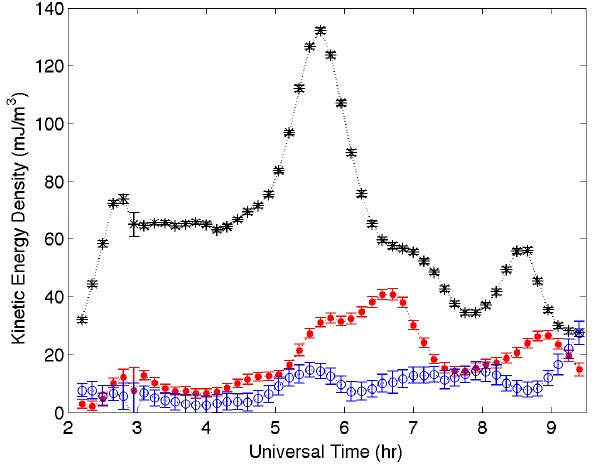
Figure 1. Kinetic energy density as a function of time for the Low (the upper stratosphere, 30 to 50 km; black asterisks), Middle (the lower mesosphere, 45 to 65 km; red solid circles) and High (the upper mesosphere, 60 to 80 km; blue open circles) regions on September 4, 1994. The vertical bars are the statistical error of each measurement. The means of the 3 regions are Low: 64 mJ/m 3 , Middle: 18 mJ/m 3 , High: 9.3 mJ/m 3 . Converted to potential energy per unit mass the measurements would have means of 28, 39 and 178 J/kg respectively.